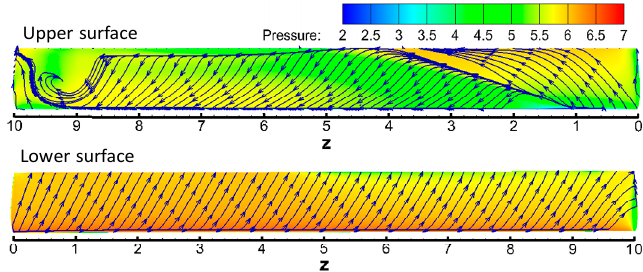
Figure 12. Pressure and streamline distributions of a finite wing on upper and lower surfaces.